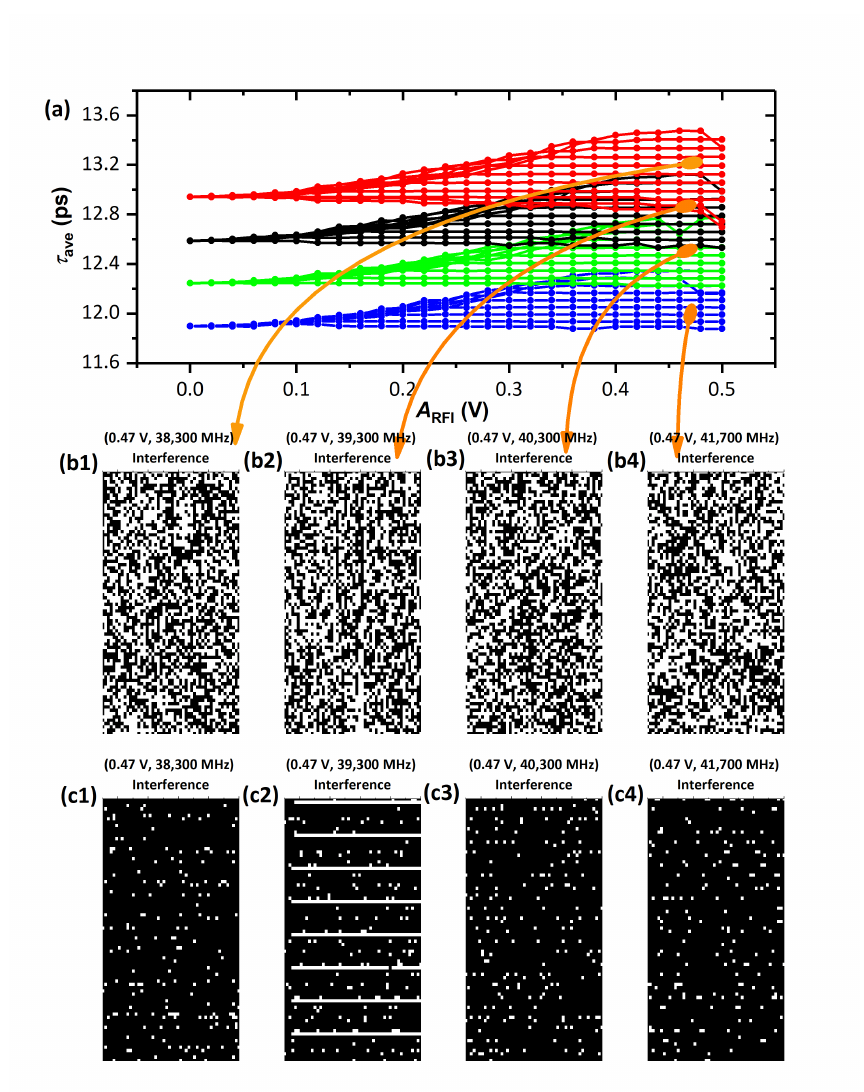
Figure 13. CMOS process-independent verification: ( a ) locking cones of ROs with different capacitor loads; ( b1 – b4 ) bitstream maps with different capacitor loads; ( c1 – c4 ) bitstream maps with all ROs loaded with 0, 0.037, 0.074, or 0.111 fF capacitors,